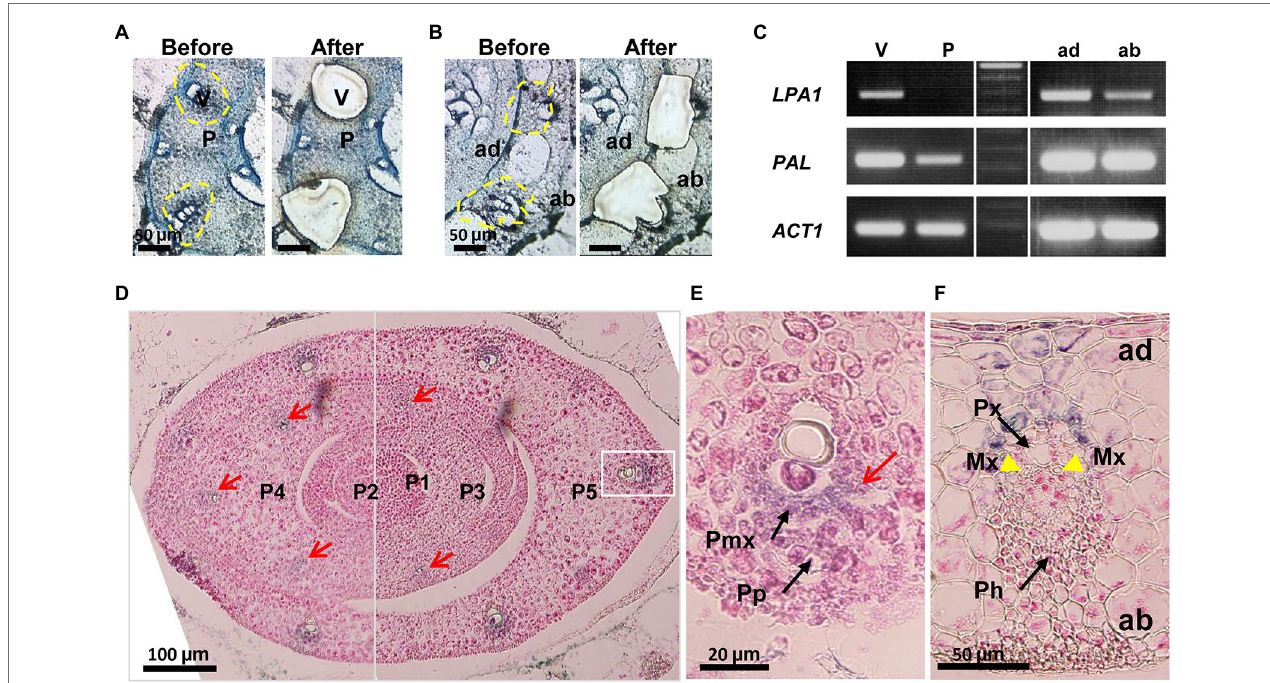
FIGURE 3 | The expression patterns of LPA1 in the vasculature of leaf primordia. (A,B) Cross sections of fifth leaf primordium (A) and leaf sheath pulvini (B) used for Laser Capture Microdissection (LCM). Left panel “Before” shows primordia before LCM while the right panel “After” shows those after LCM. V, vascular bundle; P, parenchyma tissue; ad, adaxial side leaf; ab, abaxial side leaf. (C) Semi-quantitative RT-PCR with cells collected by LCM. Phenylalanine ammonia-lyase ( PAL ) was used as a marker of vascular initiation and lignin accumulation. Actin1 ( ACT1 ) was used for normalization. (D) GUS expression in leaf primordia. Red arrows indicate GUS stains in the early vascular zones. P1–P5 indicate the leaf primordium number. (E) Section of vascular magnified white line box on the (d). GUS stains (red arrow) in vasculature at the stage of P5. Black arrows indicate pre-phloem (Pp) and pre-metaxylem (Pmx). (F) The absence of GUS expression (arrows) at the mature stage of vasculature. Yellow arrow heads indicate the enlarged metaxylem (Mx). Black arrows indicate protoxylem (Px) and phloem (Ph). Scale bars are shown in each